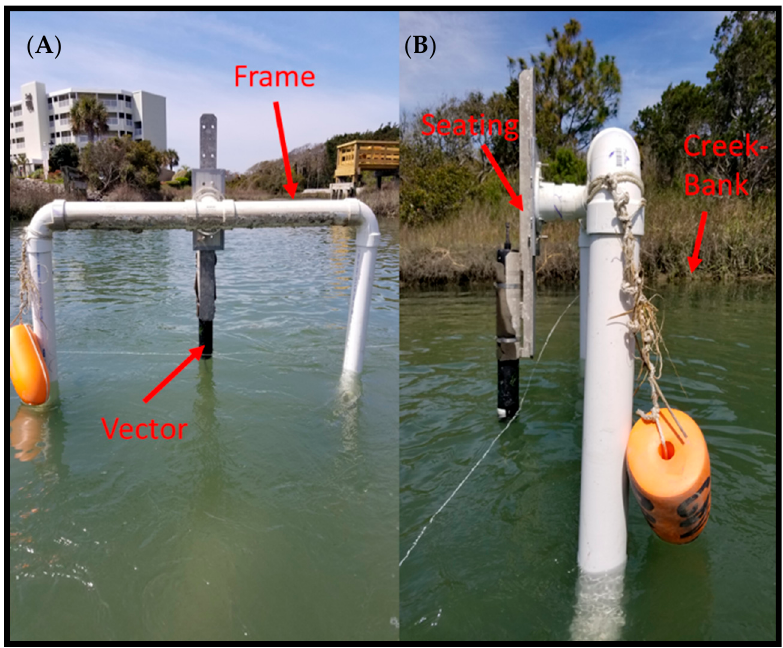
Figure 2. ( A ) along-channel and ( B ) cross-channel view of the Vector , seating, and frame at low tide. The Vector is approximately centered across the channel width.